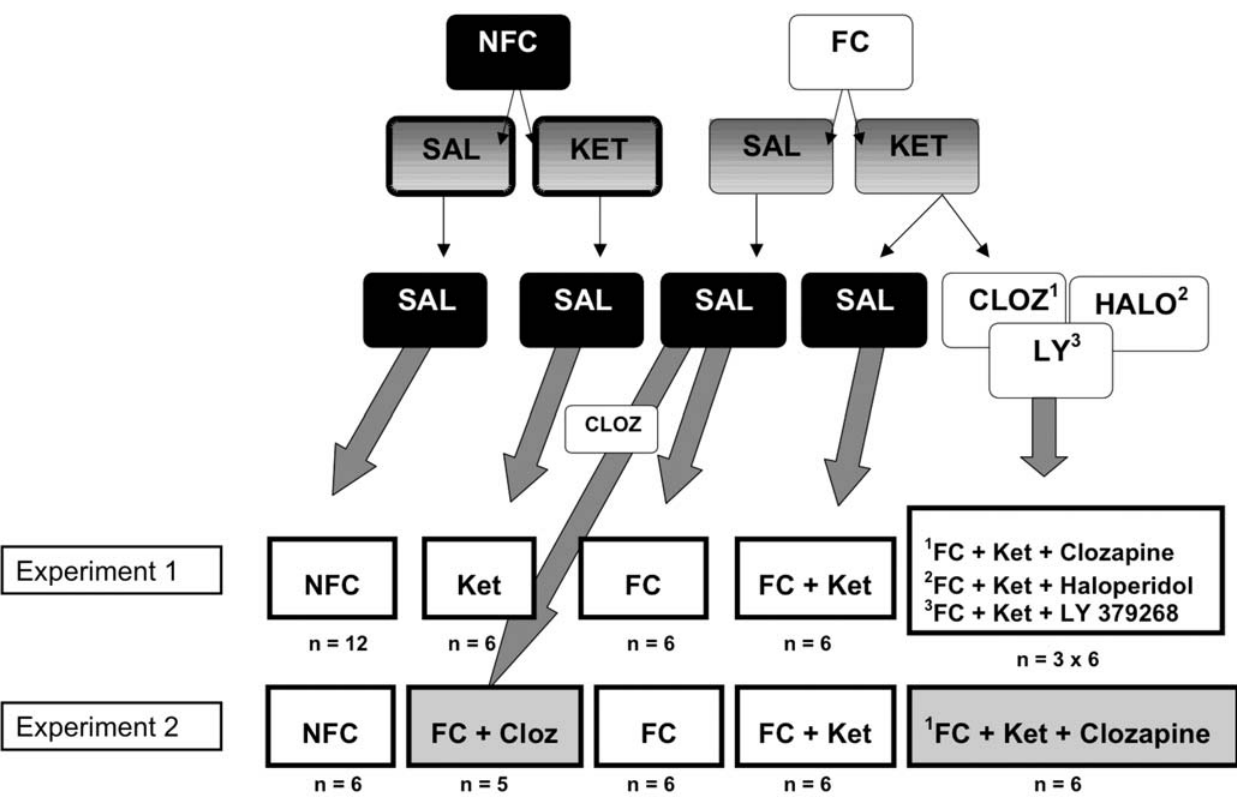
Figure 2. Experimental group divisions. Diagram portraying the rat group divisions. At the top of the hierarchy, we divided rats into two main groups: those receiving fear conditioning, and those not. Those animals receiving fear conditioning, were then further divided into rats receiving ketamine administration and rats receiving saline shams. The latter group would form the fear conditioning only group (FC). The rats not receiving fear conditioning were also divided into two groups depending on whether they would receive a ketamine or saline injection; the former group making up the ketamine only group (Ket), and the latter being the control group (NFC). The remaining fear conditioned rats also receiving ketamine were then further divided into those receiving either a saline injection (FC + Ket) or those receiving an additional antipsychotic injection consisting of clozapine (FC + Ket + CLOZ), haloperidol (FC + Ket + HALO), or LY 379268 (FC + Ket + LY). CLOZ, clozapine; FC, Fear conditioning; HALO, haloperidol; KET, ketamine; LY, LY379268; NFC, no fear conditioning; SAL,